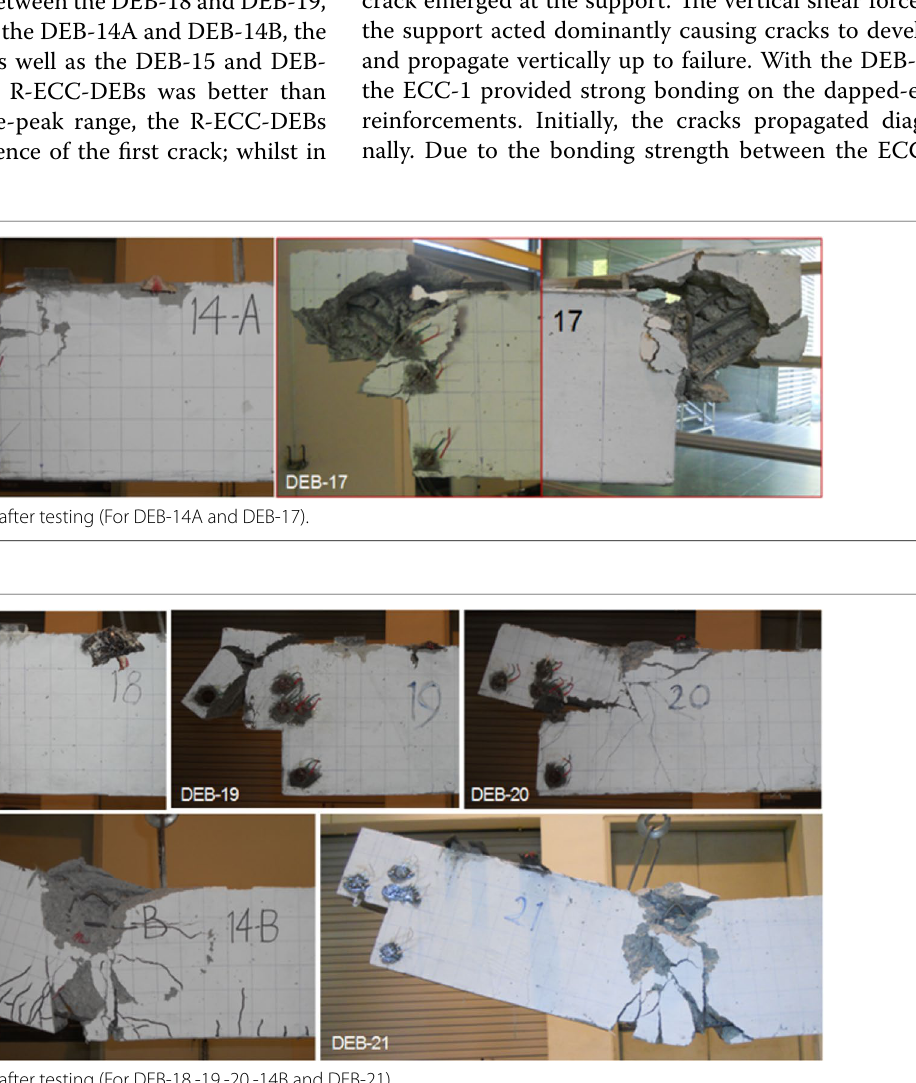
Fig. 19 The beams condition after testing (For DEB-18,-19,-20,-14B and